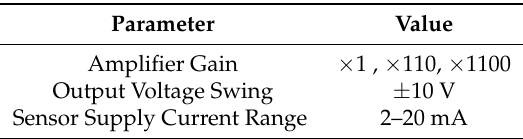
Table 4. Signal Conditioner